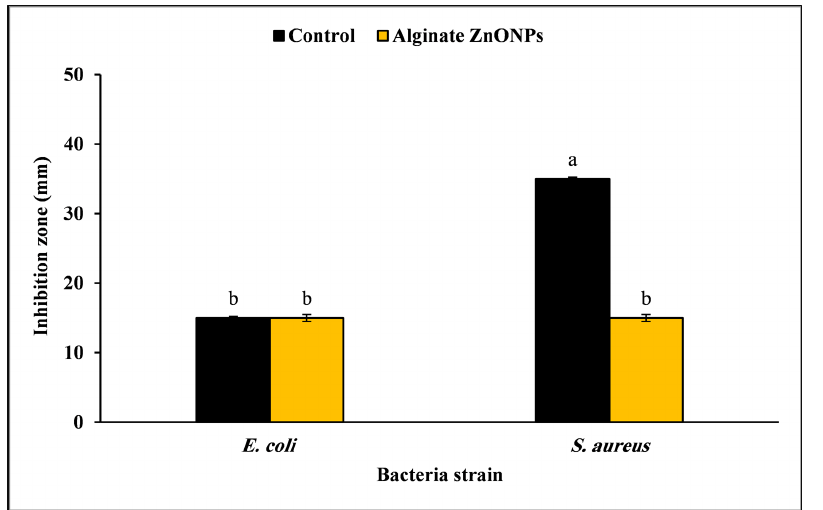
Figure 6. Inhibition zone diameter (mm) of Alg–ZnO NPs against Escherichia coli and Staphylococcus aureus compared to control (polymyxin antibiotic) using well diffusion method; vertical bars represent the standard error (SE). Bars marked with the same letter are not significantly different with 95% confidence according to Duncan’s multiple range test.